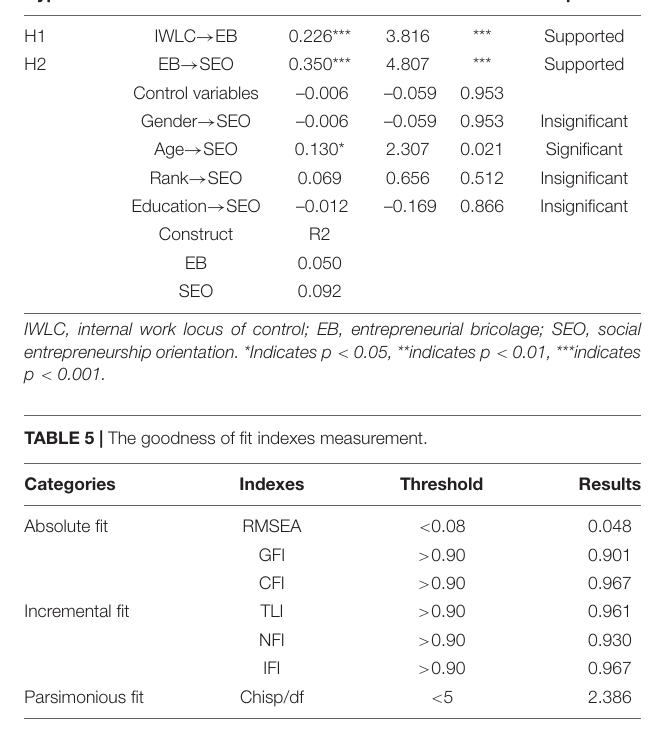
TABLE 6 | Bootstrap test for mediating